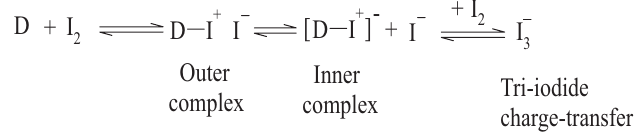
FIGURE 3 - Reaction pathway for the formation of electron donor-acceptor complex and radical ion between ALB and picric